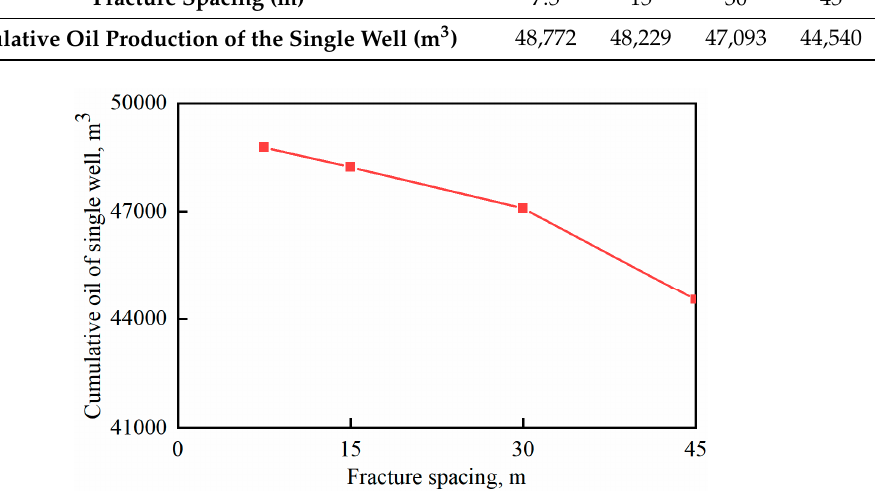
Figure 20. The relationship between cumulative oil production and fracture spacing in the single